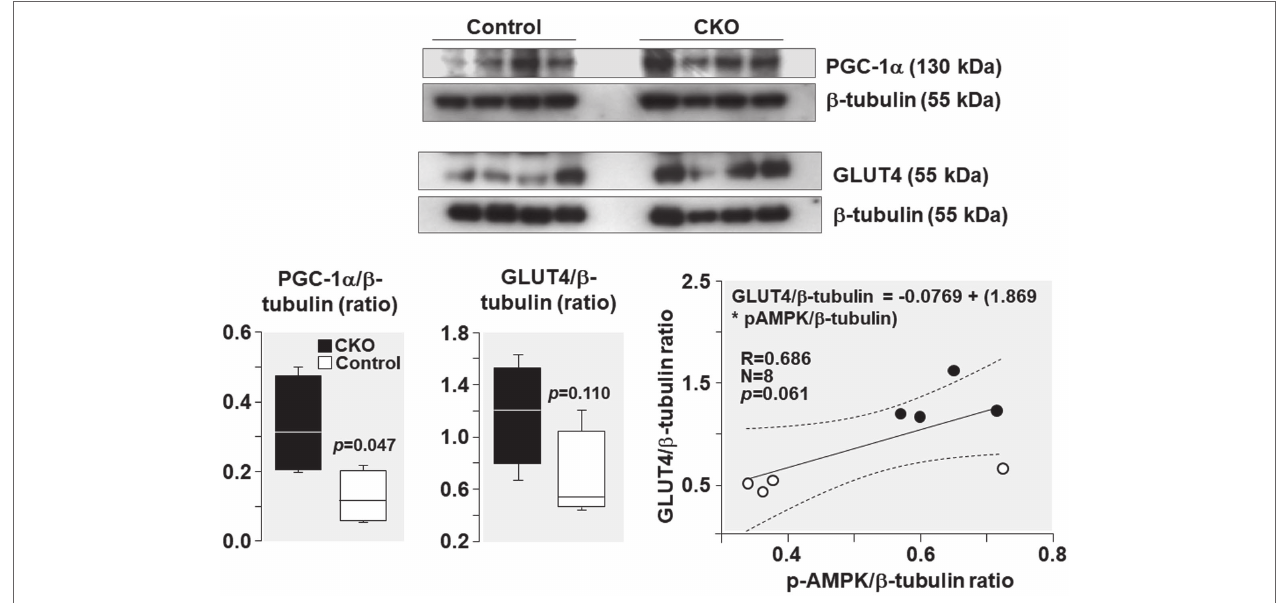
FIGURE 6 | Western blots demonstrating levels of PGC-1 α , GLUT4, and β -tubulin (loading control) in mice skeletal muscle after exercise. Box plots denote densitometry of PGC-1 α and GLUT4 normalized to β -tubulin. N = 4 from each group. Relationship between pAMPK/ β -tubulin ratio and GLUT4/ β -tubulin ratio is shown. The regression line is shown with the corresponding 95% confidence interval.